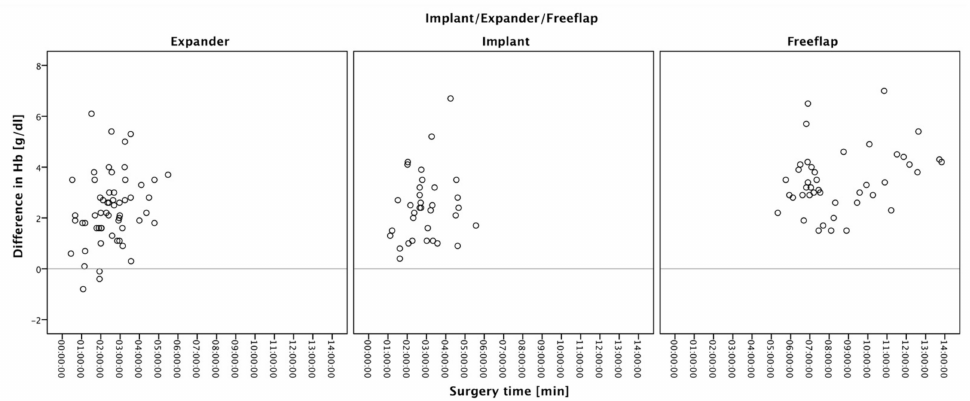
Figure 1. Scatter plot correlation of surgery duration and hemoglobin loss: patients undergoing autologous tissue reconstruction or reconstruction with definitive breast implants showed a weak (but not significant) correlation of hemoglobin loss and procedure time (autologous tissue reconstruction: τ τ b = 0.147, p = 0.170; definitive implants: b = 0.099, p = 0.414). Patients reconstructed with tissue expanders showed a significantly increased postoperative hemoglobin loss correlating with surgery duration (tissue expander: τ b = 0.201, p =